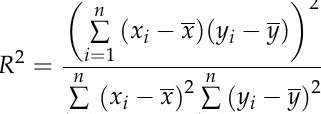
Figure 15. Schematic diagram of neuron parameter setting.